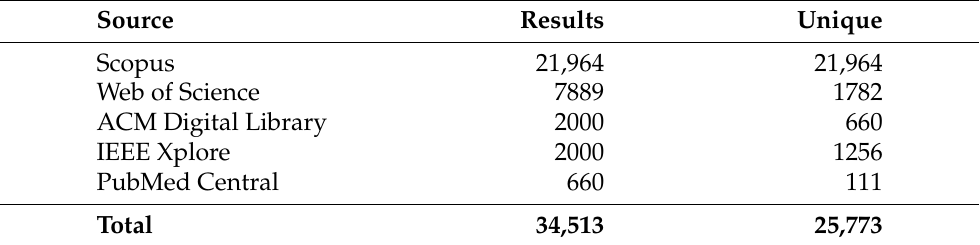
Table 3. Statistics regarding the different databases used in the search